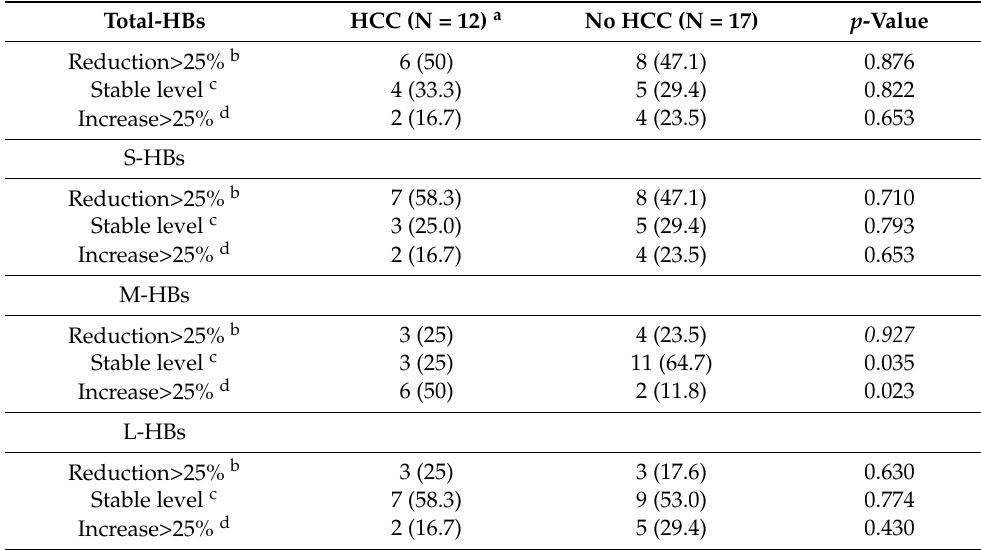
Table 4. On treatment kinetics in the different HBs isoforms in HCC and non-HCC